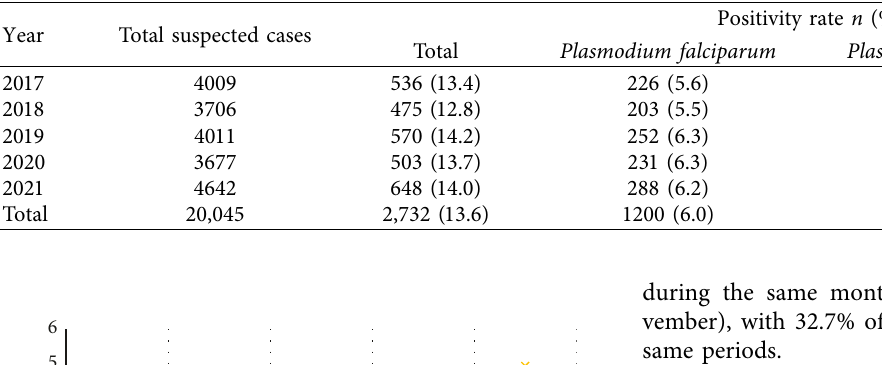
Table 2: Slide positivity rates and Plasmodium species composition of malaria parasite in Decha and Gimbo districts, Southwest Ethiopia